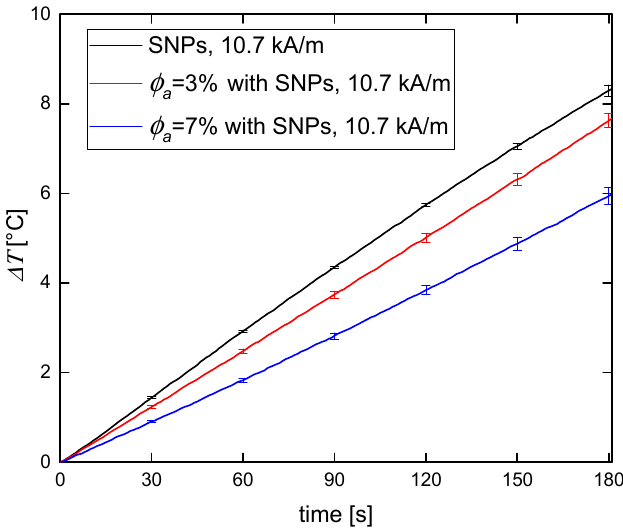
Figure 5. Temperature increase for SNPs suspended in water and embedded in 3% and 7% agar phantom for 10.7 kA/m of the magnetic field.